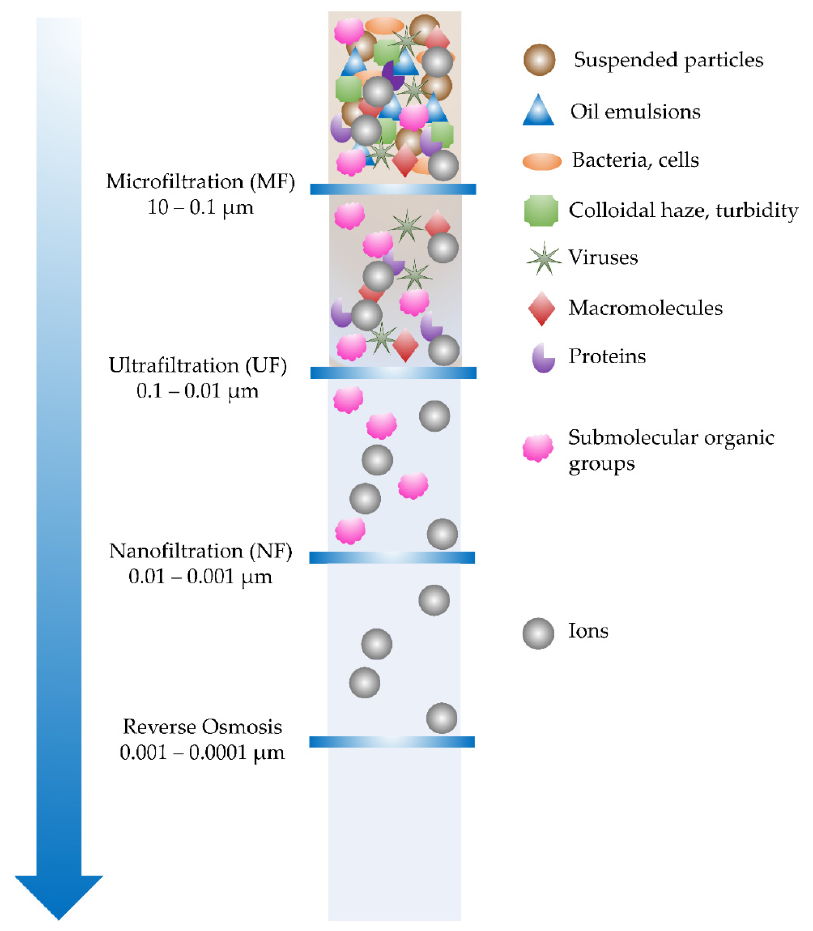
Figure 12. Type of membrane filtration: microfiltration (MF), ultrafiltration (UF), nanofiltration (NF), and reverse osmosis (RO).